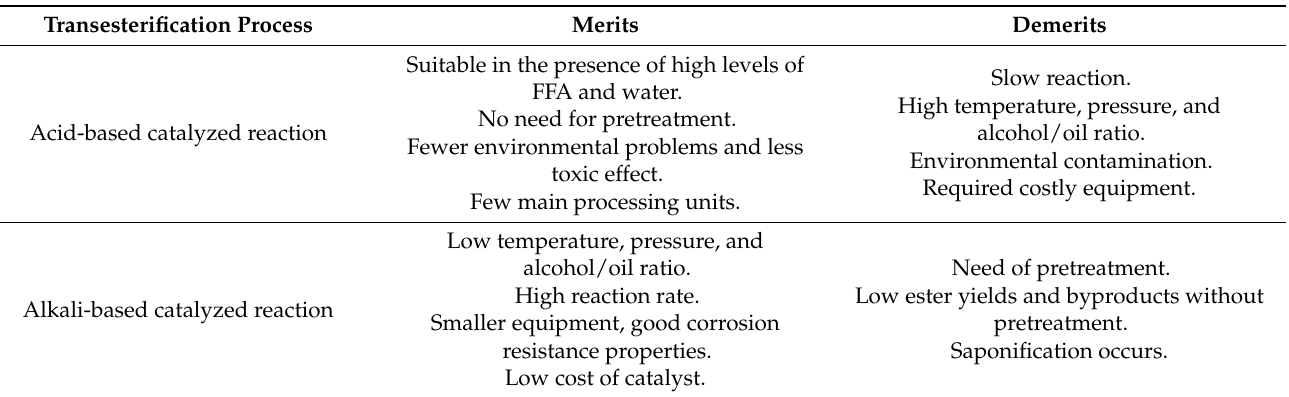
Table 7. Comparison of acid versus alkali-catalyzed transesterification process of biodiesel production, reported by [27].